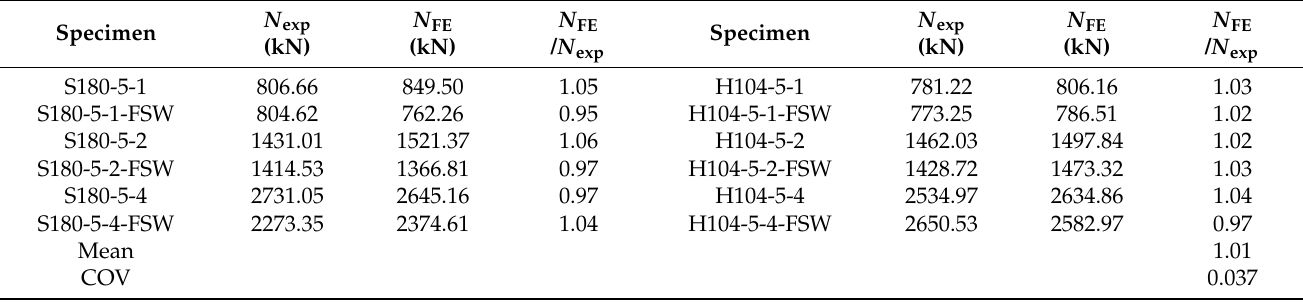
Table 3. Experimental and numerical compression capacities of honeycomb specimens.